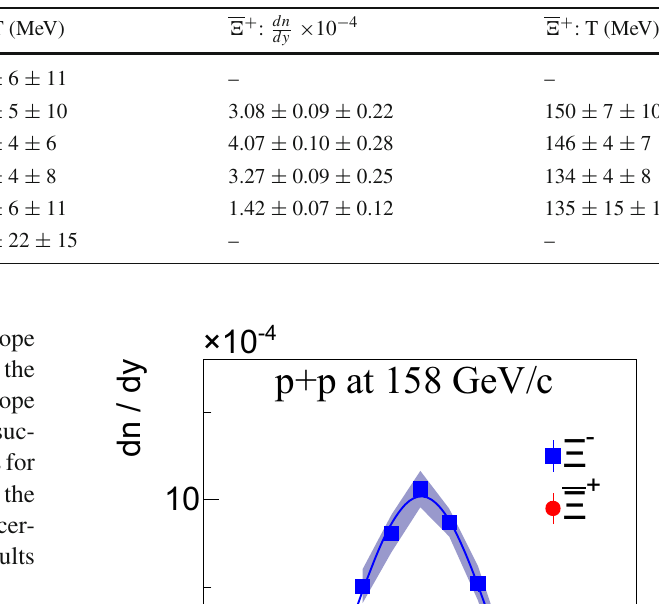
the middle of the presented bin. First value is the multiplicity, second represents the statistical uncertainty and third one corresponds to the estimated systematic uncertainty